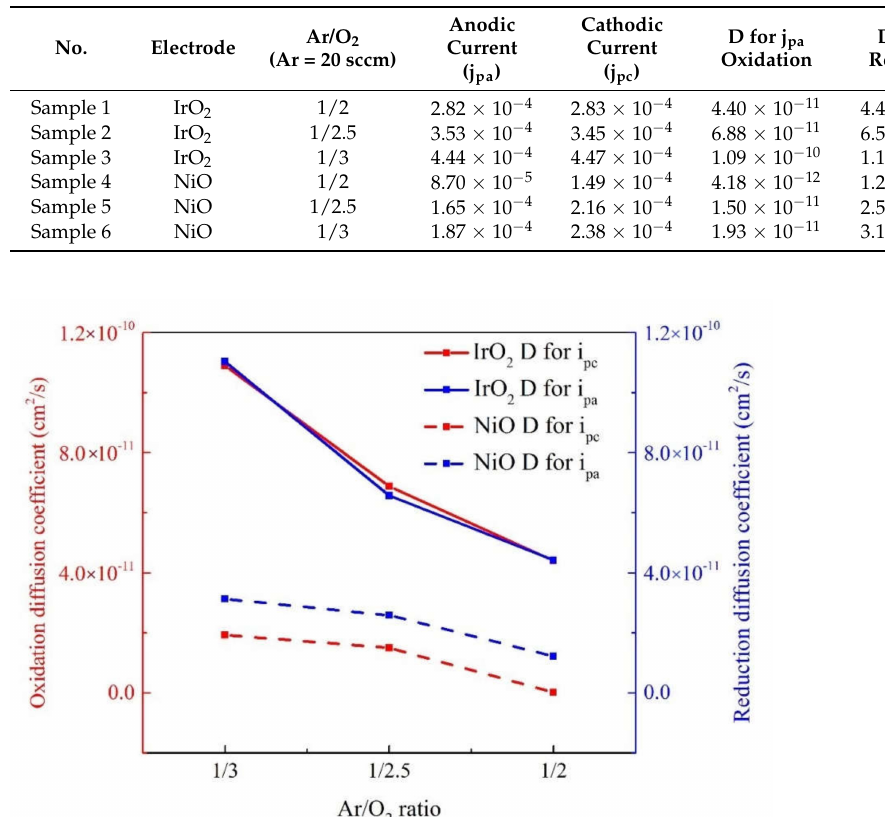
Figure 2. Comparison of 25th cycle CV curve of IrO 2 (solid line) and NiO (dotted line) electrode films at a potential sweep rate of 100 mV/s. Table 3. Diffusion coefficients of IrO 2 and NiO electrodes with various Ar/O 2 mixing ratios.